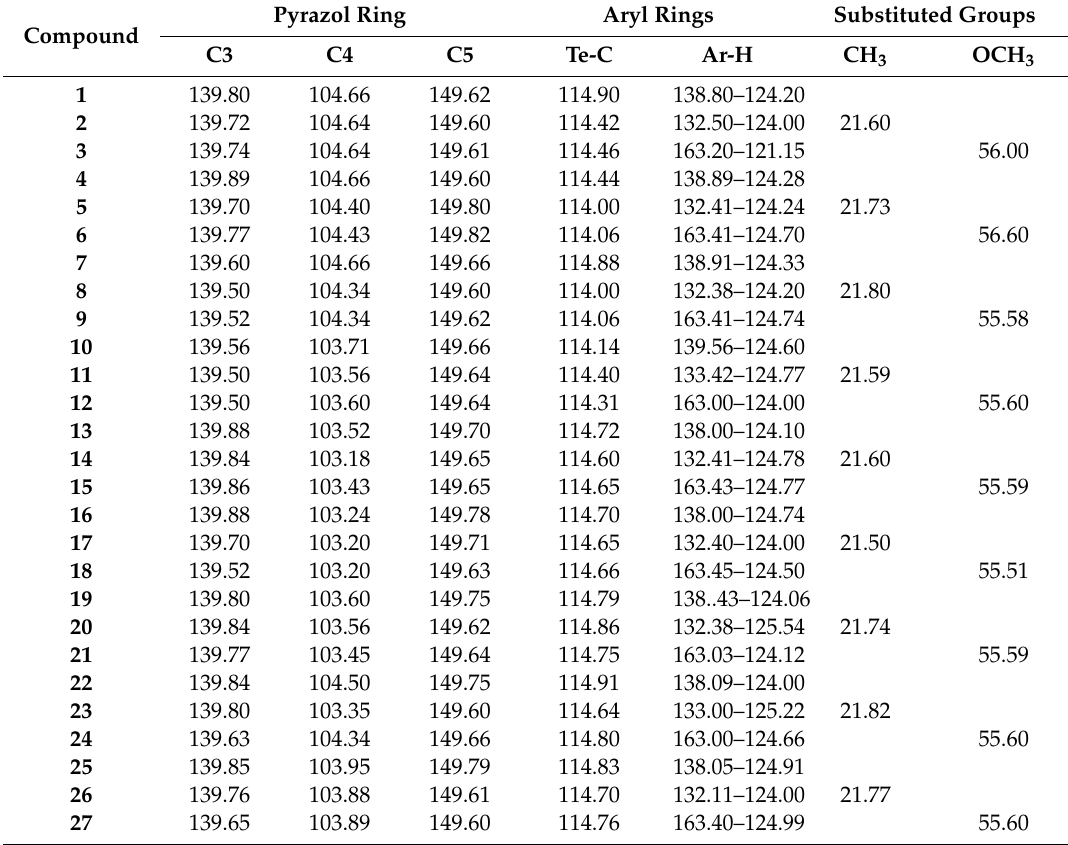
Table 1. 13 C NMR chemical shifts for compounds 1 – 15 in DMSO- d 6